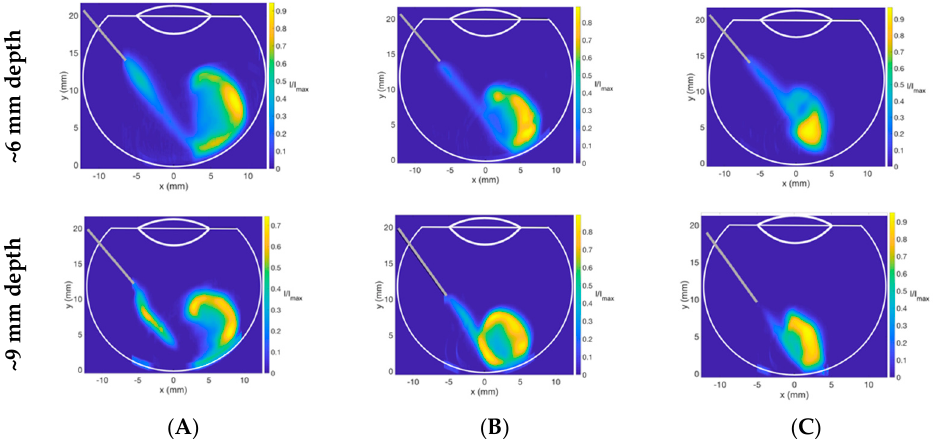
Figure 17. Side view contour plots of Coomassie blue dye injected into ( A ) 1.0, ( B ) 2.0 and ( C ) 3.0 mg/mL HA at high Re (677 ± 175) at needle depths of (upper panel) approximately 6 mm and (lower panel) 9 mm. Deeper needle placement may be preferable for delivering